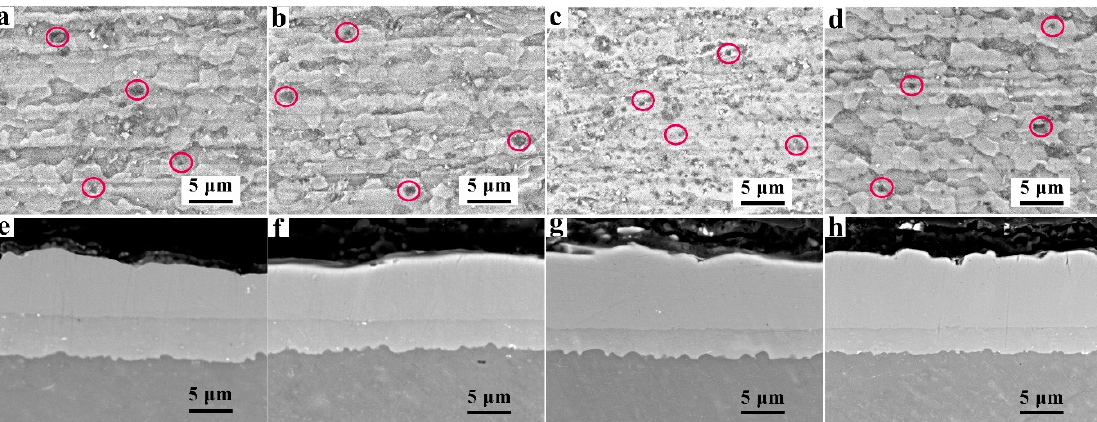
Figure 5. The SEM planar view and ( e – h ) the cross-sectional morphologies of the Al coating after 350 ◦ C heat treatment for 4 h with Zn immersion for ( a , e ) 2 min, ( b , f ) 4 min, ( c , g ) 6 min, and ( d , h ) 8